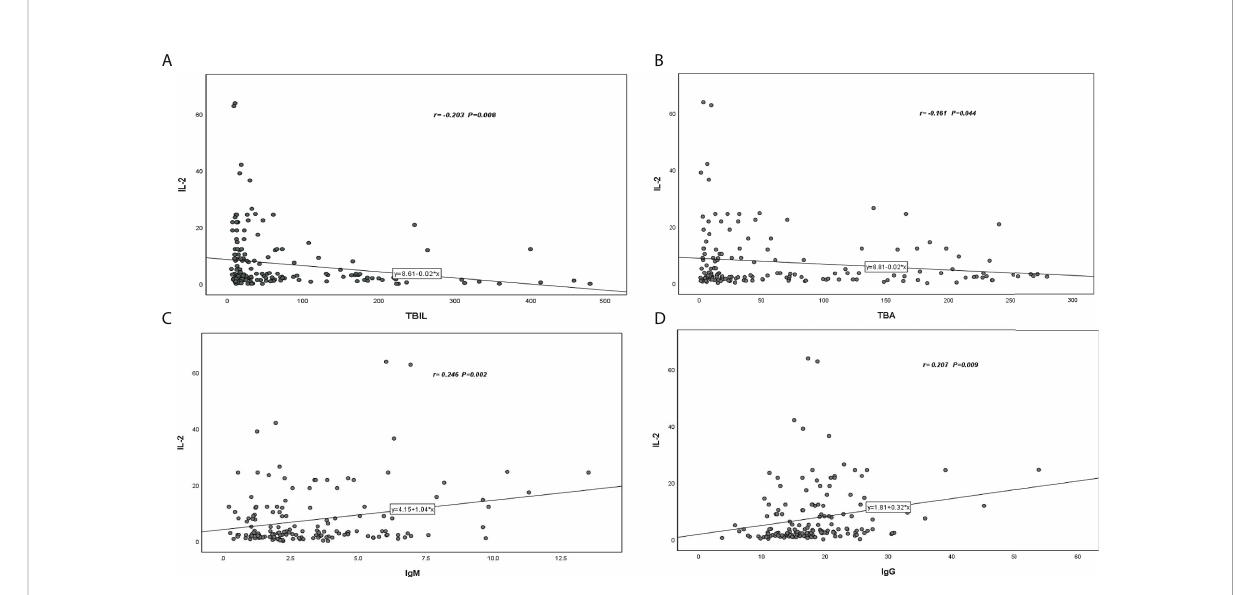
FIGURE 1 Correlation coef fi cient and P -value between serum IL-2 level and various parameters of patients with PBC. (A) Serum IL-2 was negatively correlated with TBIL (r=-203). (B) Serum IL-2 was negatively correlated with TBA (r=-161). (C) Serum IL-2 was positively correlated with IgM (r=0.246). (D) Serum IL-2 was positively correlated with IgG(r=0.207).